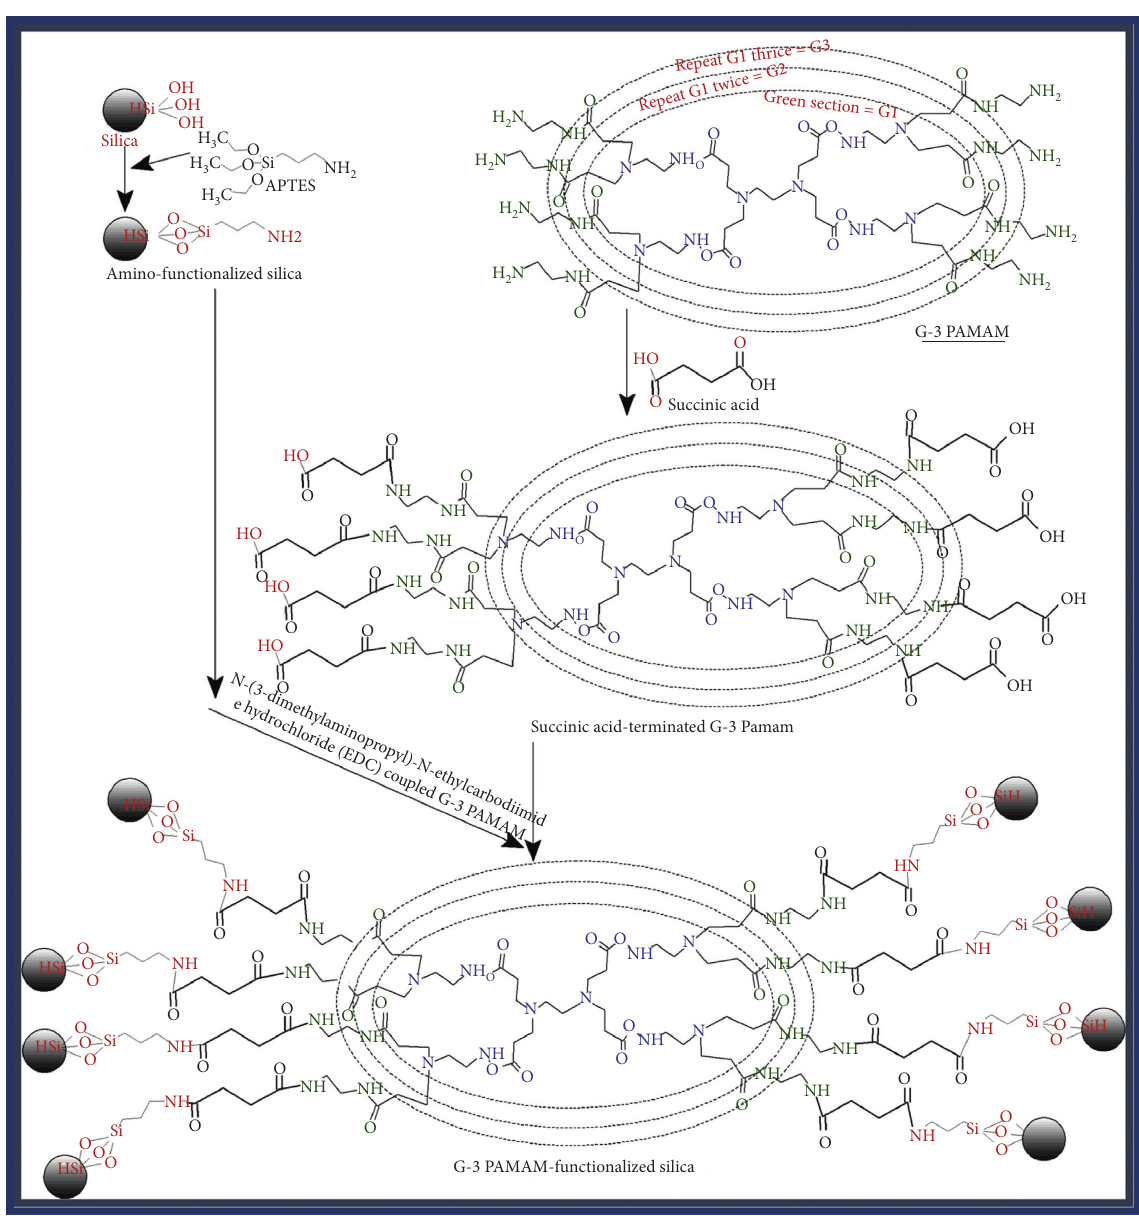
Figure 1: Schematics for the synthesis of G-3 PAMAM SGA [33]. Table 1: Physicochemical parameters of the synthesized G-3 PAMAM SGA